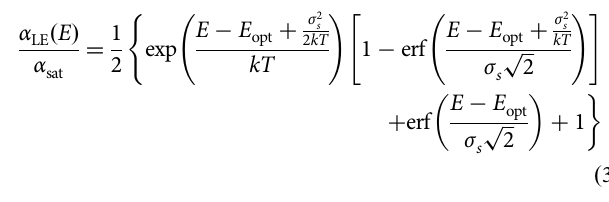
parameters summarized in Supplementary Table 1. PBDB-T: